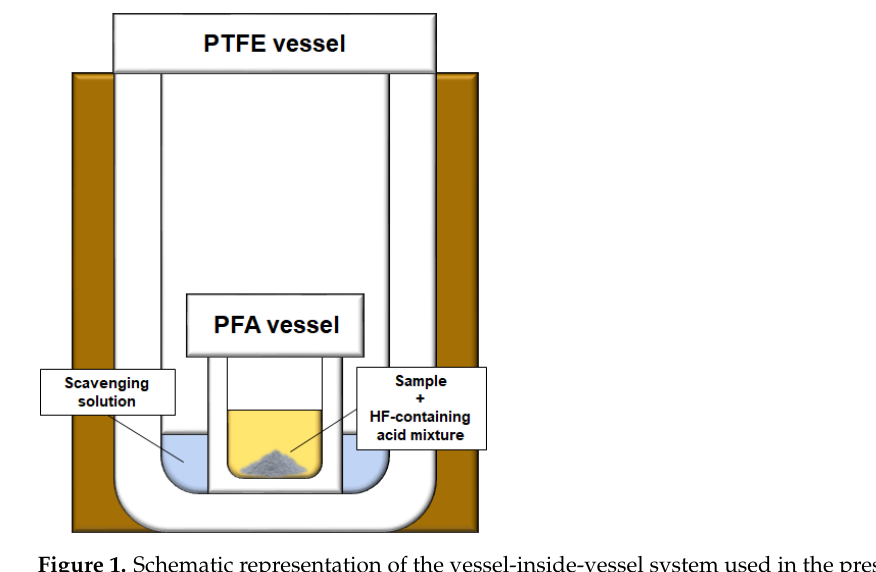
Figure 1. Schematic representation of the vessel-inside-vessel system used in the present work.